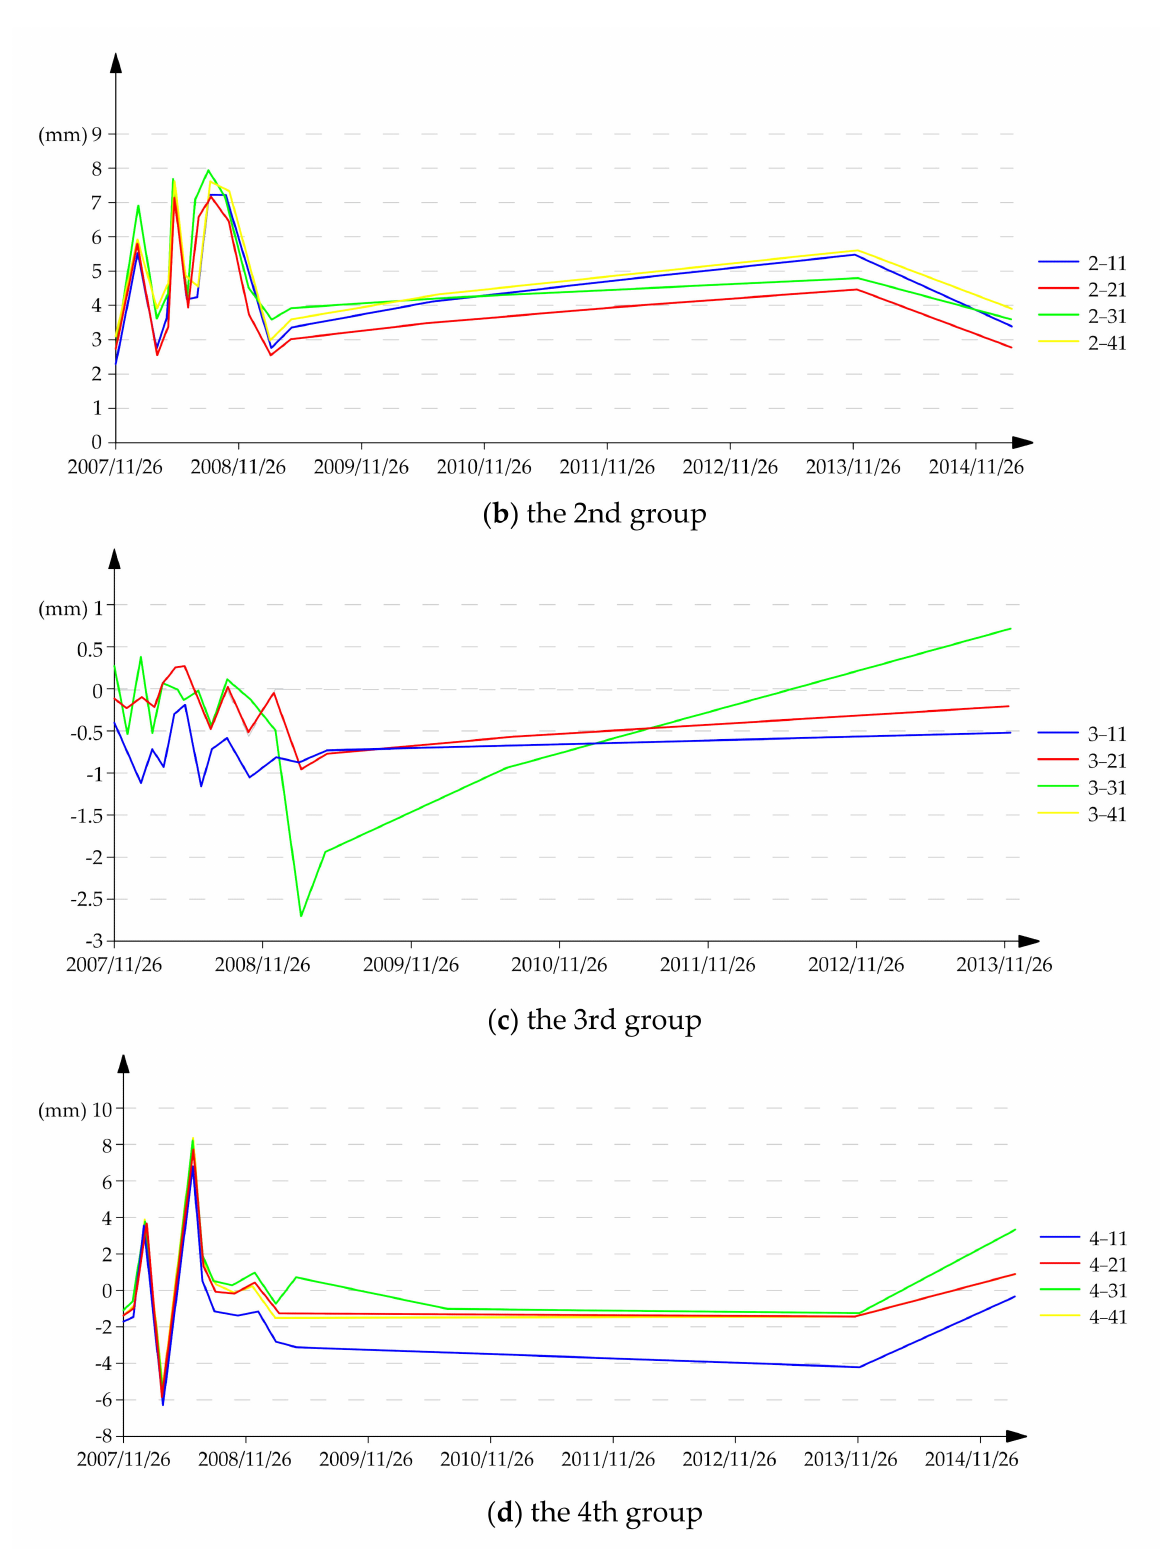
Figure 9. Accumulative settlement for bedrock markers in the